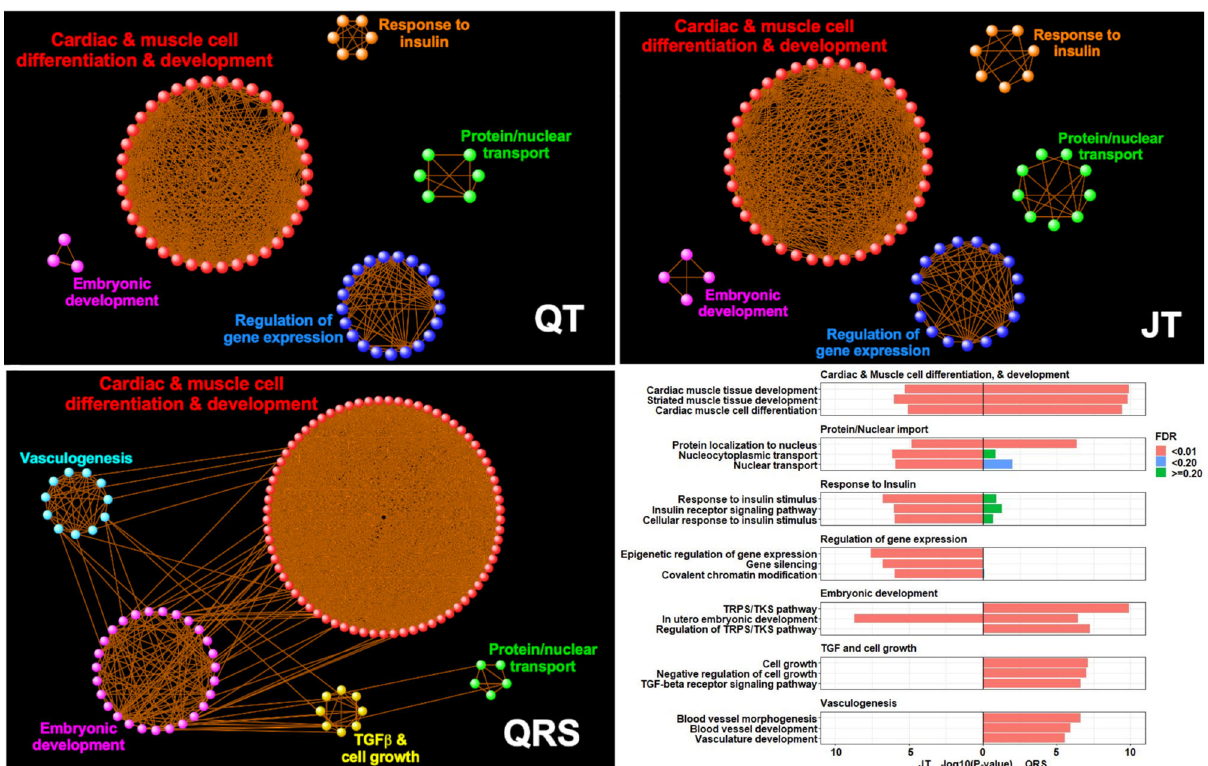
Fig. 5 | Enrichment network visualization of DEPICT GO biological processes. The fi rst three panels (QT, JT, and QRS) were created using Cytoscape (v3.8.2). Signi fi cantGObiologicalprocesses(falsediscoveryrate[FDR]<0.01)fromDEPICT pathway analyses (represented as a colored point in the image) were linked toge- ther (light orange line) when containing a minimum of 25% overlap of gene mem- bers. Orphan pathways or those with less than three edges were excluded. This created discrete “ modules ” of interlinked pathways, from which common themes